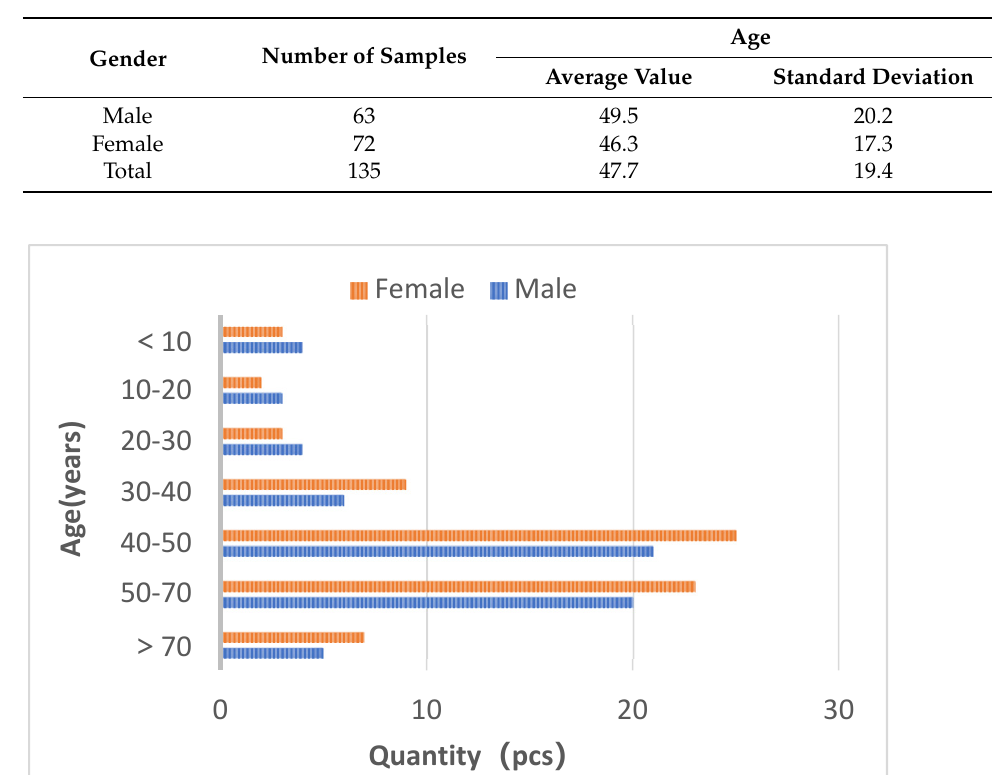
Table 2. Information of the questionnaire respondents.